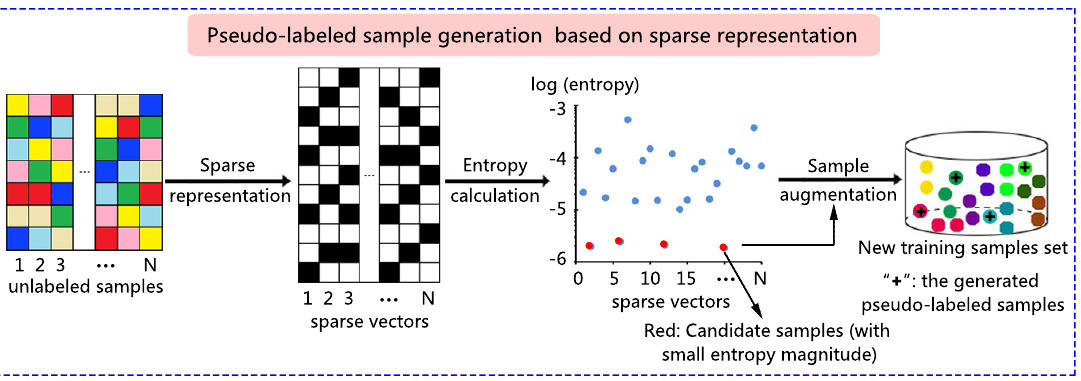
Figure 1. Graphical example illustrating the process of pseudo-labeled sample generation based on sparse representation. In the new training sample set, small balls of different colors represent different classes of training samples, and the plus sign represents a newly generated pseudo-labeled